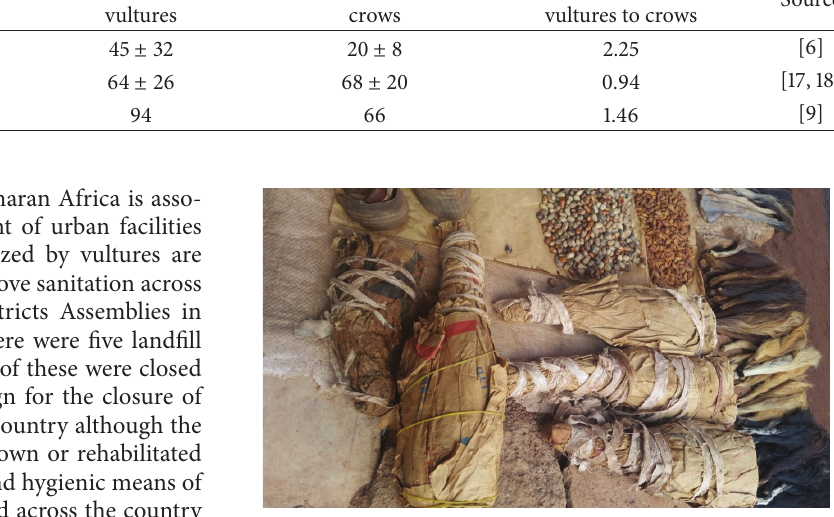
Figure 3: Exhibits of five Hooded Vulture specimens (concealed in brown paper) among other items being sold in a market at